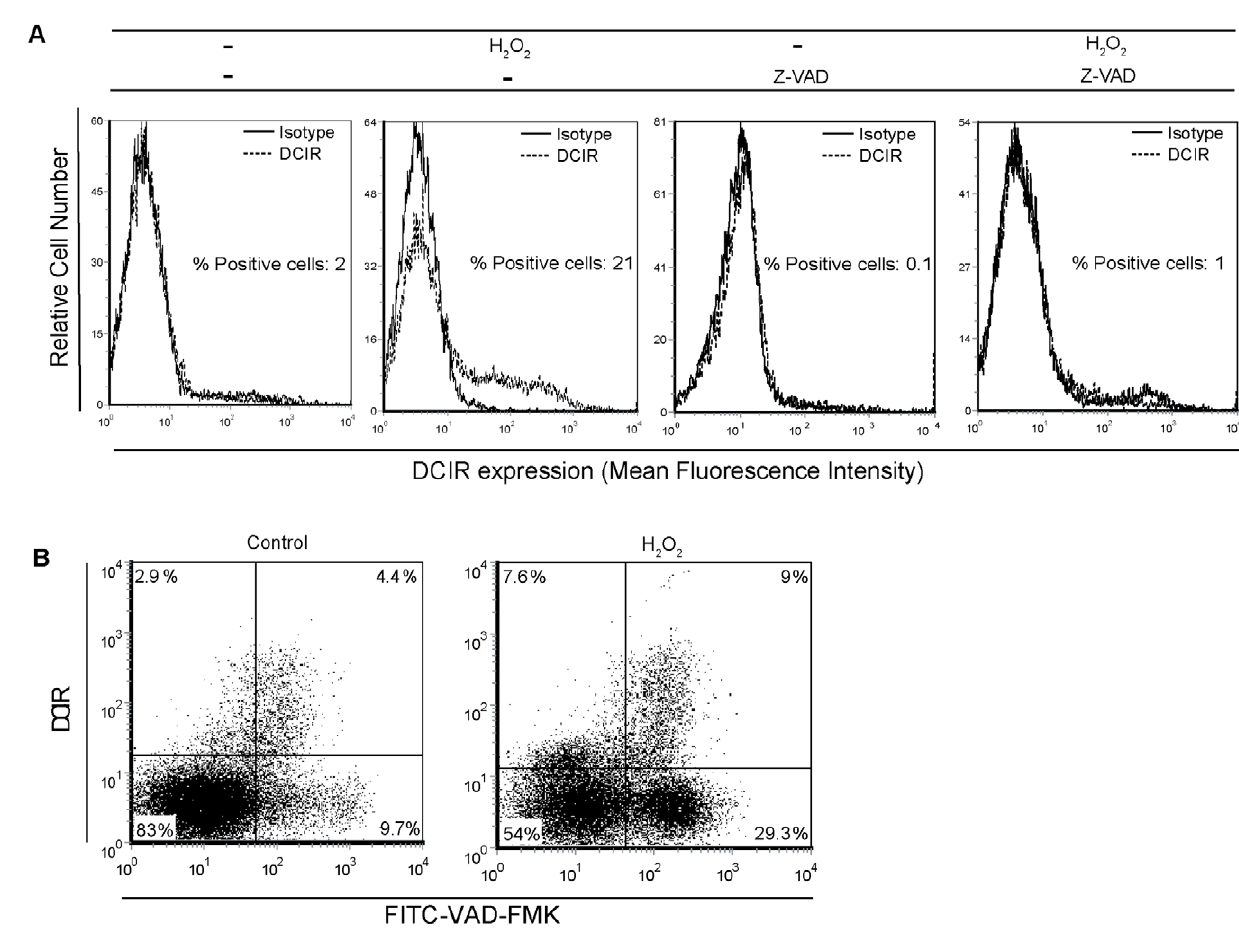
Figure 8. H 2 O 2 treatment drives DCIR expression in both nonapoptotic and apoptotic cells. (A) Mitogen-activated CD4 + T cells (1 6 10 6 ) were first either left untreated or treated for 1 h with the caspase inhibitor Z-VAD-FMK (50 nM), after which H 2 O 2 (30 m M) was added, where indicated. DCIR expression was monitored 16 h later by flow cytometry. Expression of DCIR is shown as a dotted line, whereas the continuous line represents staining obtained with an isotype-matched irrelevant control Ab. Data shown correspond to a single experiment representative of 3 independent experiments. (B) Mitogen-stimulated CD4 + T cells (1 6 10 6 ) were first treated for 16 h with H 2 O 2 (i.e. 30 m M). Thereafter, DCIR surface expression and caspase activation were monitored by flow cytometric analysis using a double-staining method consisting of FITC-VAD-FMK followed by the R-PE-conjugated anti-DCIR. Data shown correspond to a single experiment representative of 4 independent experiments.